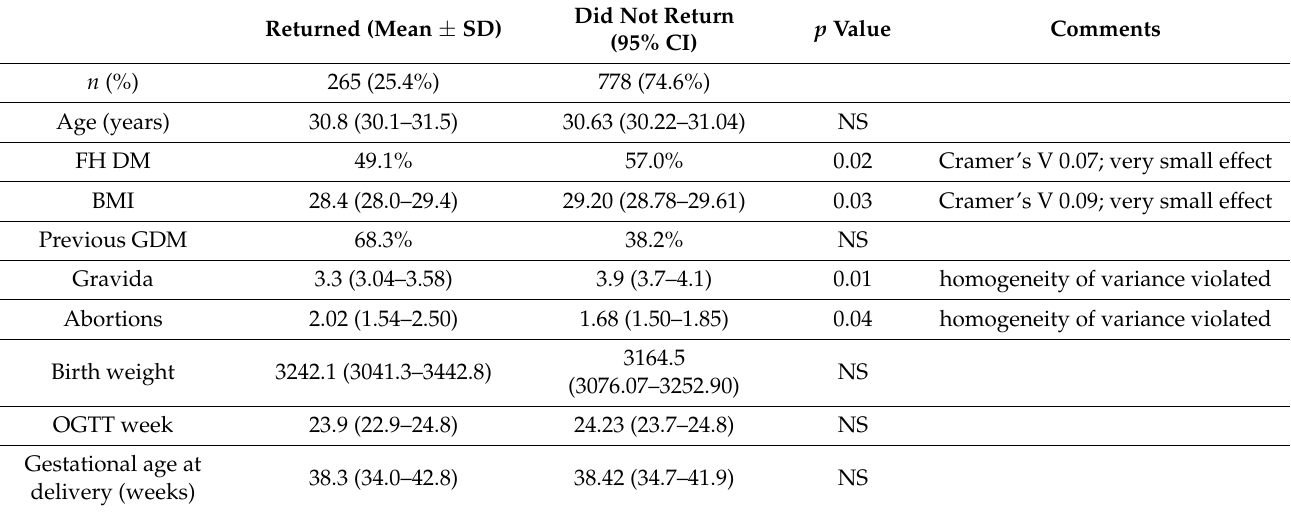
Table 1. Comparison of women who did and did not return for an oral glucose tolerance